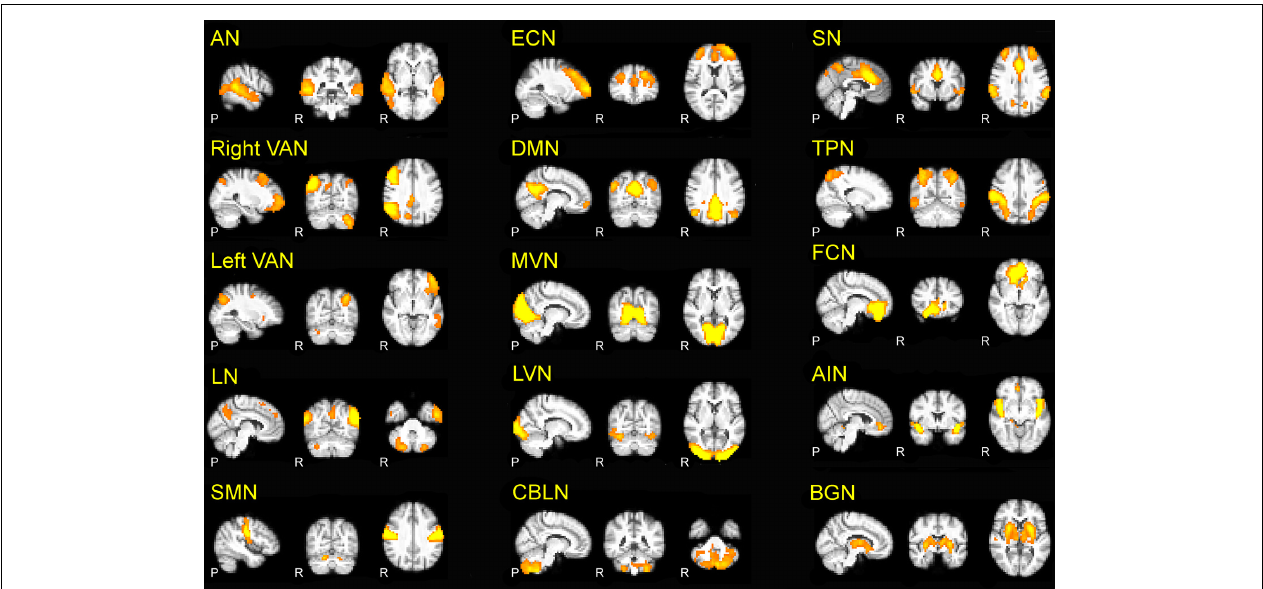
FIGURE 1 | The 15 RSNs identified in the present investigation. Auditory network (AN), right and left ventral attention networks (VAN), language network (LN), sensory-motor network (SMN), executive control network (ECN), default mode network (DMN), medial visual network (MVN), lateral visual network (LVN), cerebellar network (CBLN), salience